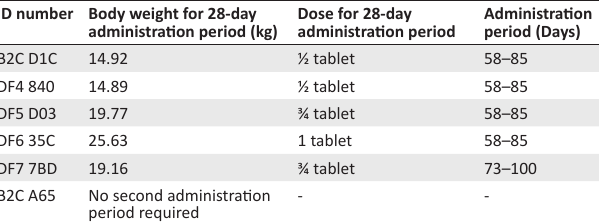
TABLE 2b: Study day (Day) and dose administered to each respective dog during the 28-day administration